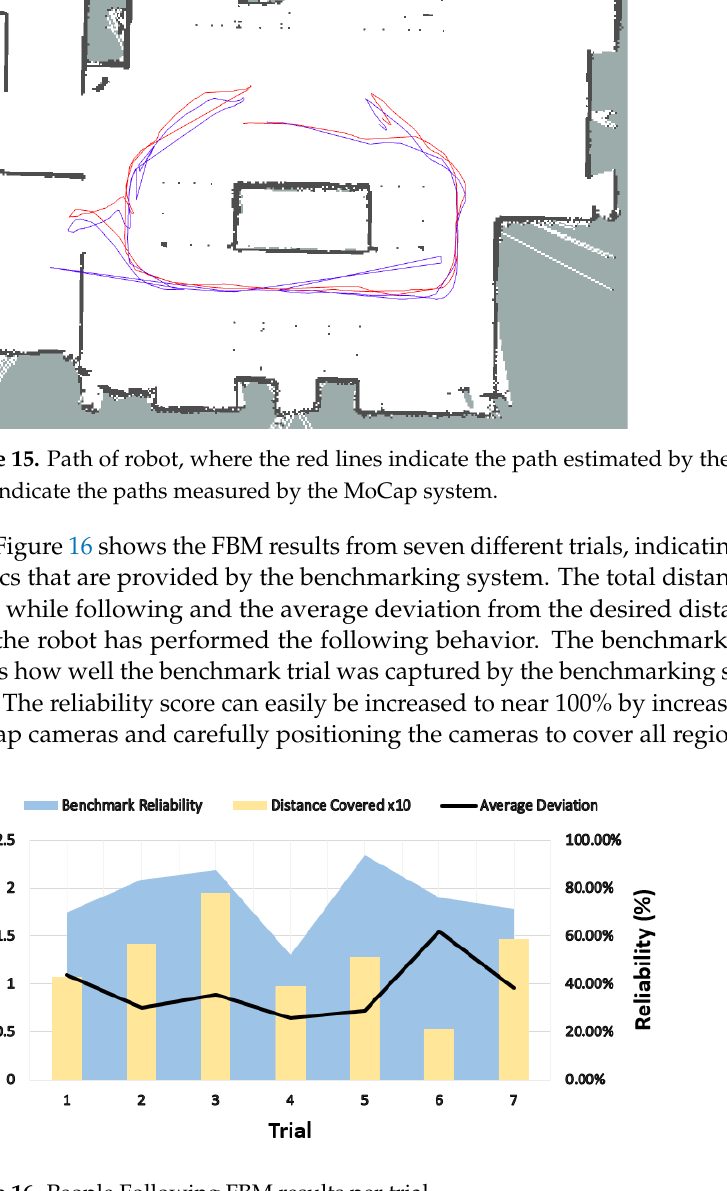
Figure 16. People Following FBM results per